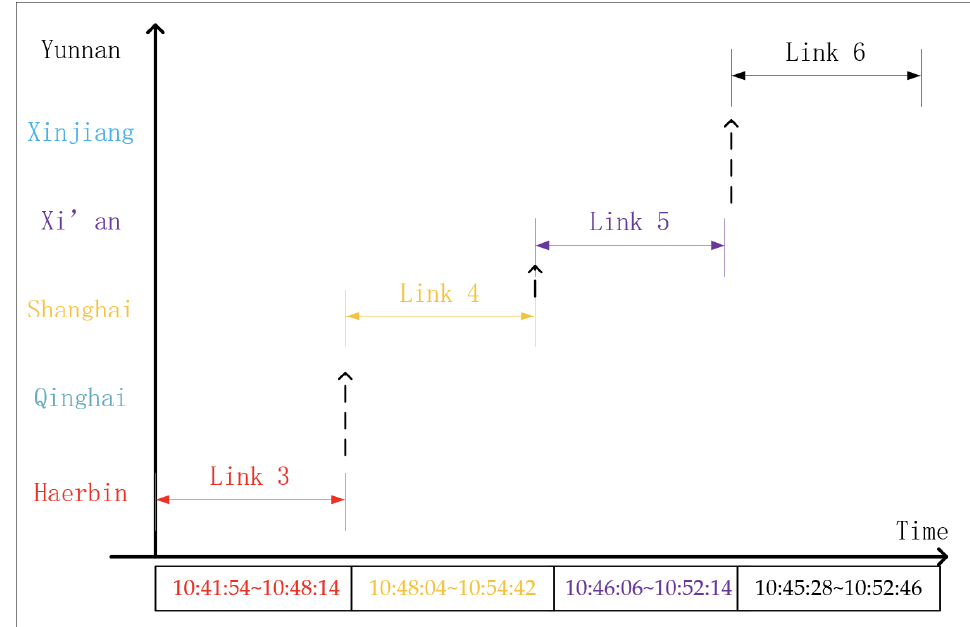
Figure 6. Result of simulation by STK.